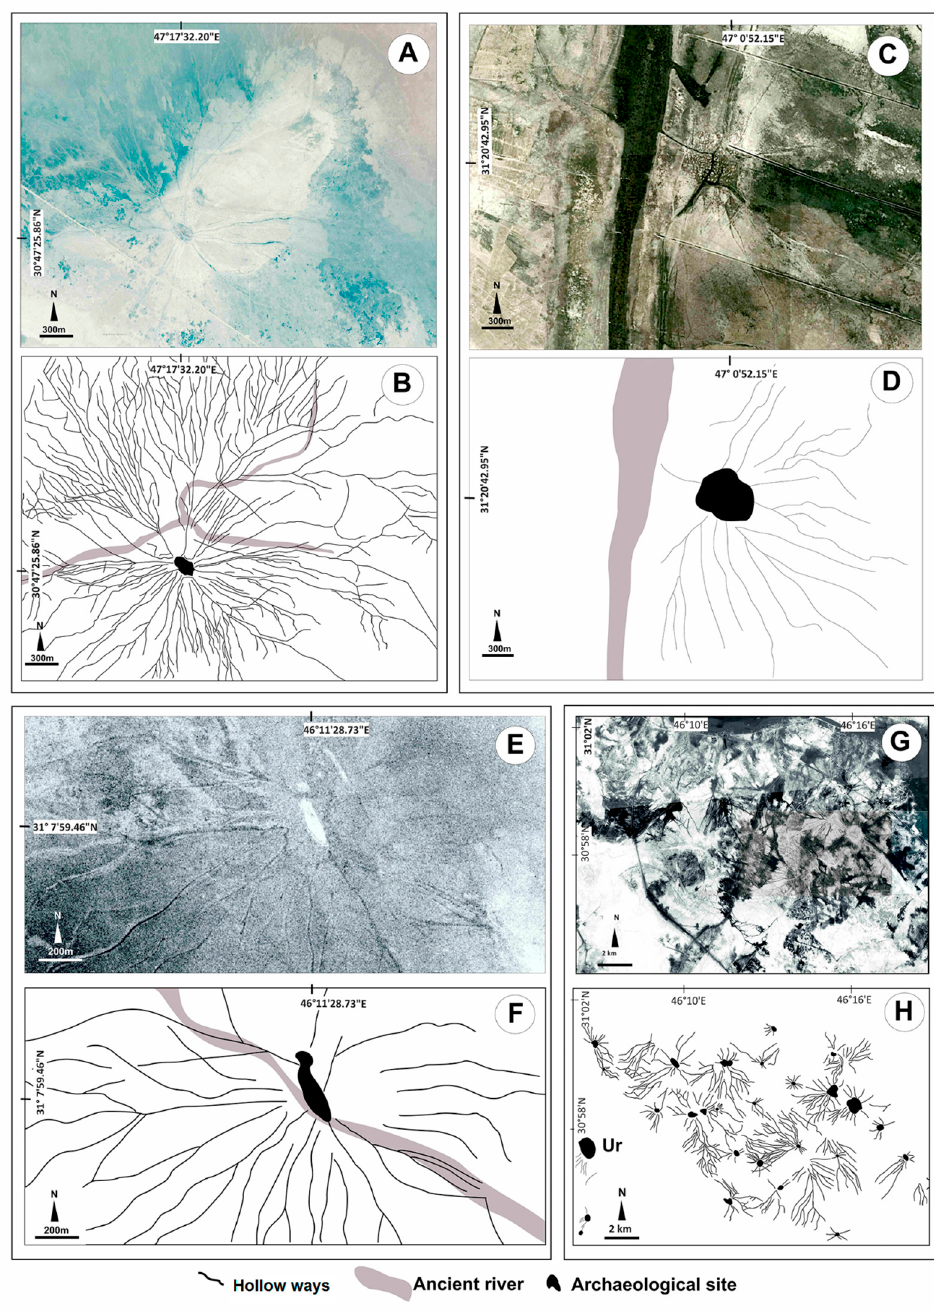
Figure 9. The hollow ways of Southern Mesopotamia appear as dark lines with lighter borders, radiating outwards from sites, but they are much narrower than the hollow ways in the North Jazira. In this figure, images and digital drawings of the hollow ways are paired (A = B, C = D, E = F, and G = H).